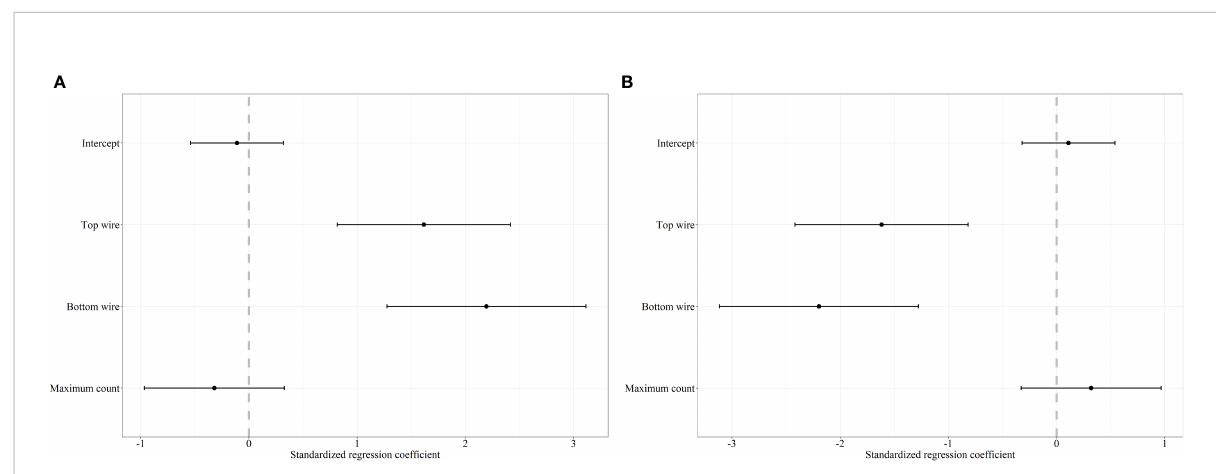
FIGURE 3 Standardized regression coef fi cients and 95% CI for the top models of the decision to cross under (A) and over (B) a fence white-tailed deer. The regression coef fi cient for the decision of mule deer to cross under and over was averaged between two competing models with D AICc < 2.0. We considered bottom wire height, top wire height, area (reference category – AB), sex-age (reference category – adult female), maximum count, snow (reference category – absent), and treatment-period (reference category – control-before) as covariates in our mixed effects logistic regression analysis. Covariates whose 95% CI overlap 0 are considered